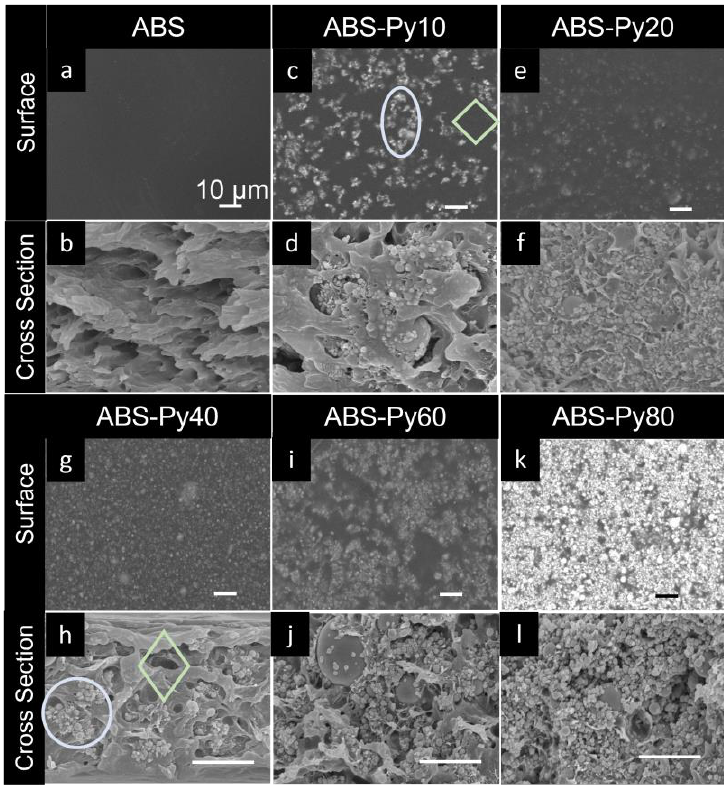
Figure 3. Scanning electron microscopy (SEM) surface ( top ) and cross section ( bottom ) representative images at magnifications of 10 k × and 30 k × for the neat ABS and the composite samples with different weight percentages. The scale bars in the images represent 1 µ m and 10 µ m. ( a , b ) pure ABS. ( c – l ) ABS-PyX with increasing wt% content of